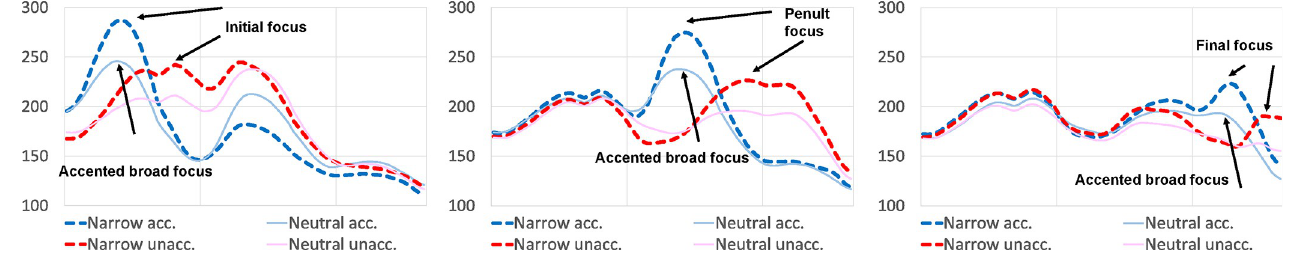
Fig 1. Averaged F0 contours of initial / penultimate / final narrow vs. neutral × accented vs. unaccented focus [data from